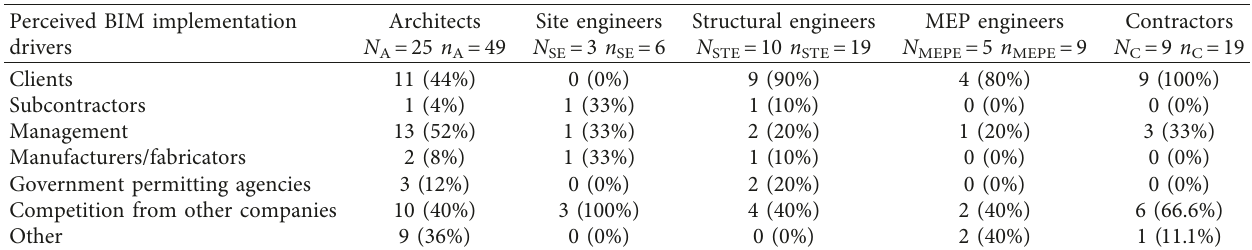
Figure 3: BIM-knowledgeable employees within disciplines ( N Table 1: Relationship between the role of the respondent and the perceived driving force for BIM implementation in educational facility projects .